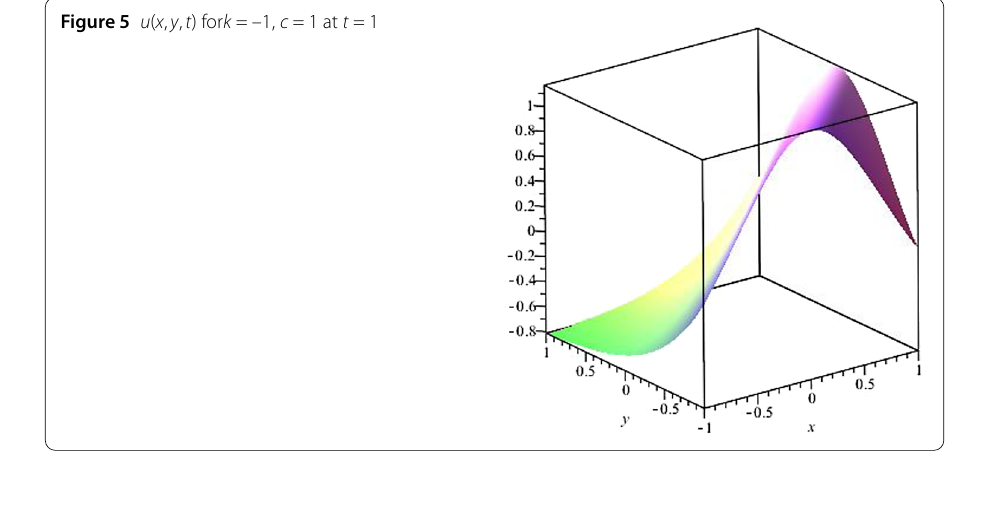
Figure 6 v ( x , y , t ) for k = –1, c = 1 at t =